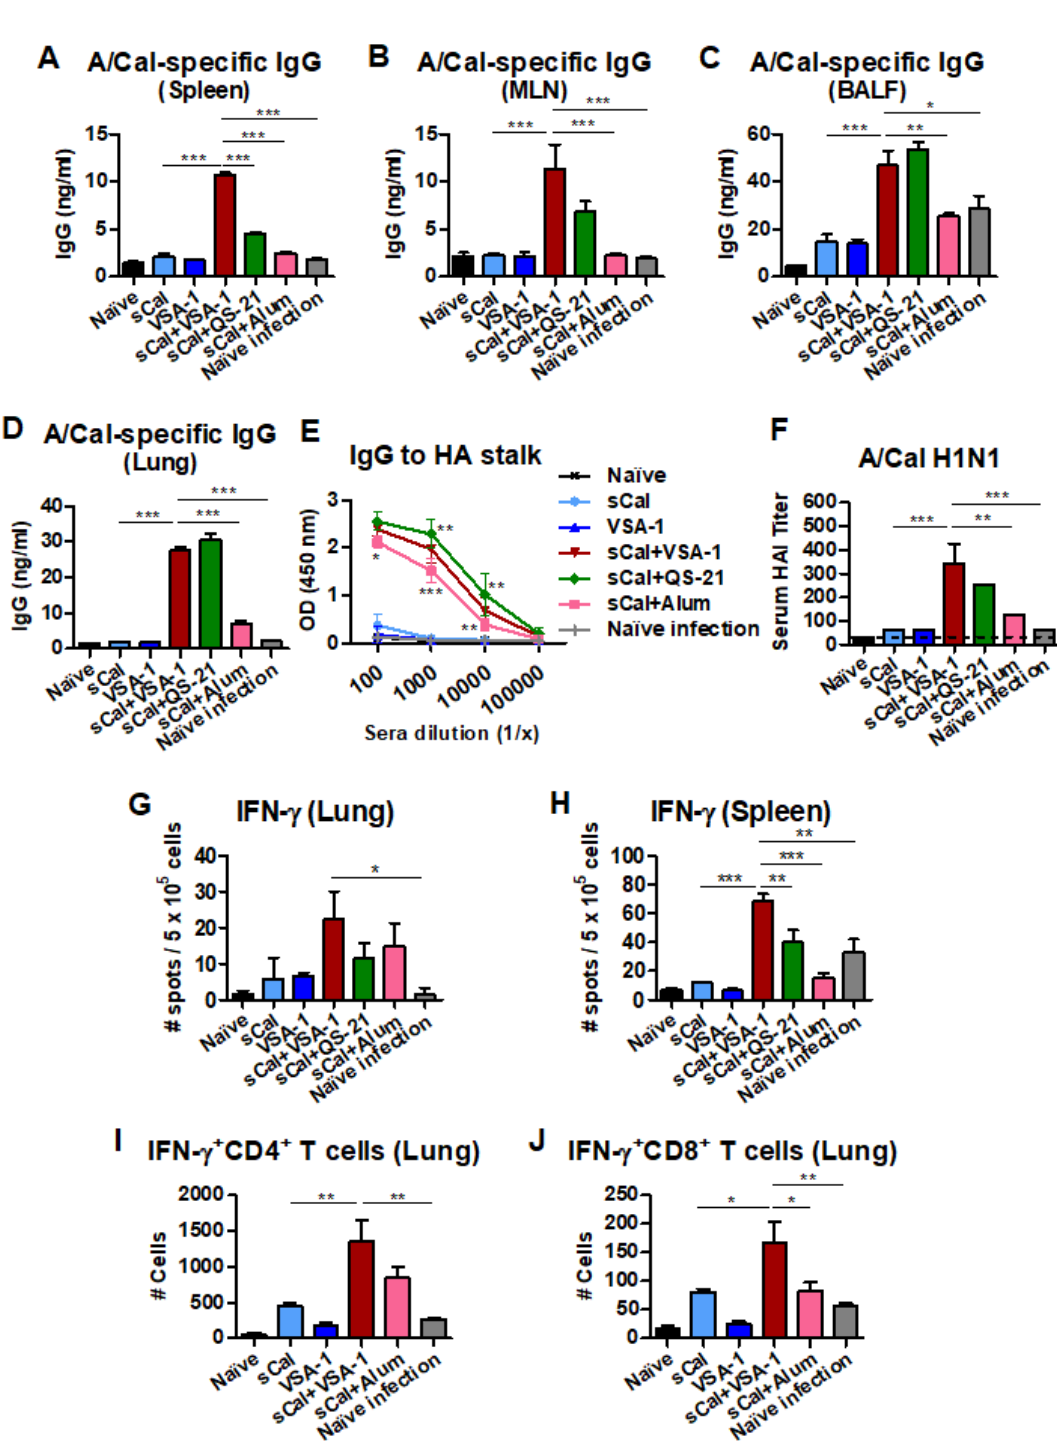
Figure 4. VSA-1-adjuvanted sCal vaccination enhances antibody-secreting cells and recall effector T cells on day 5 after A/Cal H1N1 influenza virus infection. ( A , B ) A/Cal virus-specific IgG (in vitro) production in splenocytes and MLN cells ( n = 3 per group). ( C , D ) A/Cal virus-specific IgG levels in BALF and lung samples. ( E ) Antibody responses specific for HA2 stalk in sera after challenge. ( F ) HAI titers against A/Cal H1N1 virus. ( G , H ) Cytokine ELISpot of lung cells and splenocytes after in vitro stimulation with inactivated A/Cal virus. ( I , J ) Flow cytometry data of IFN- γ -secreting CD4 + and CD8 + T cells in lung samples. Error bars indicate the mean ± SEM. *; p < 0.05, **; p < 0.01, ***; p < 0.001 compared to sCal+VSA-1 group.